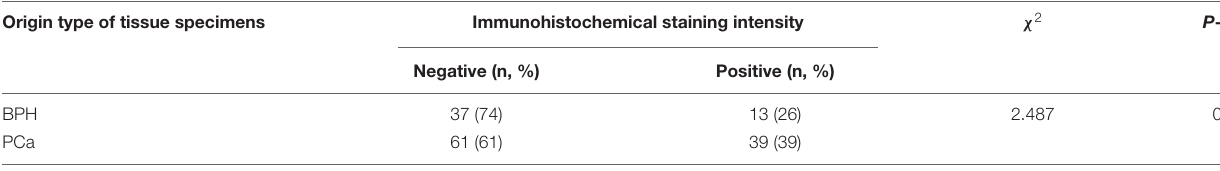
TABLE 1 | SMARCC1 expression profile in tissue from BPH and PCa. Origin type of tissue specimens